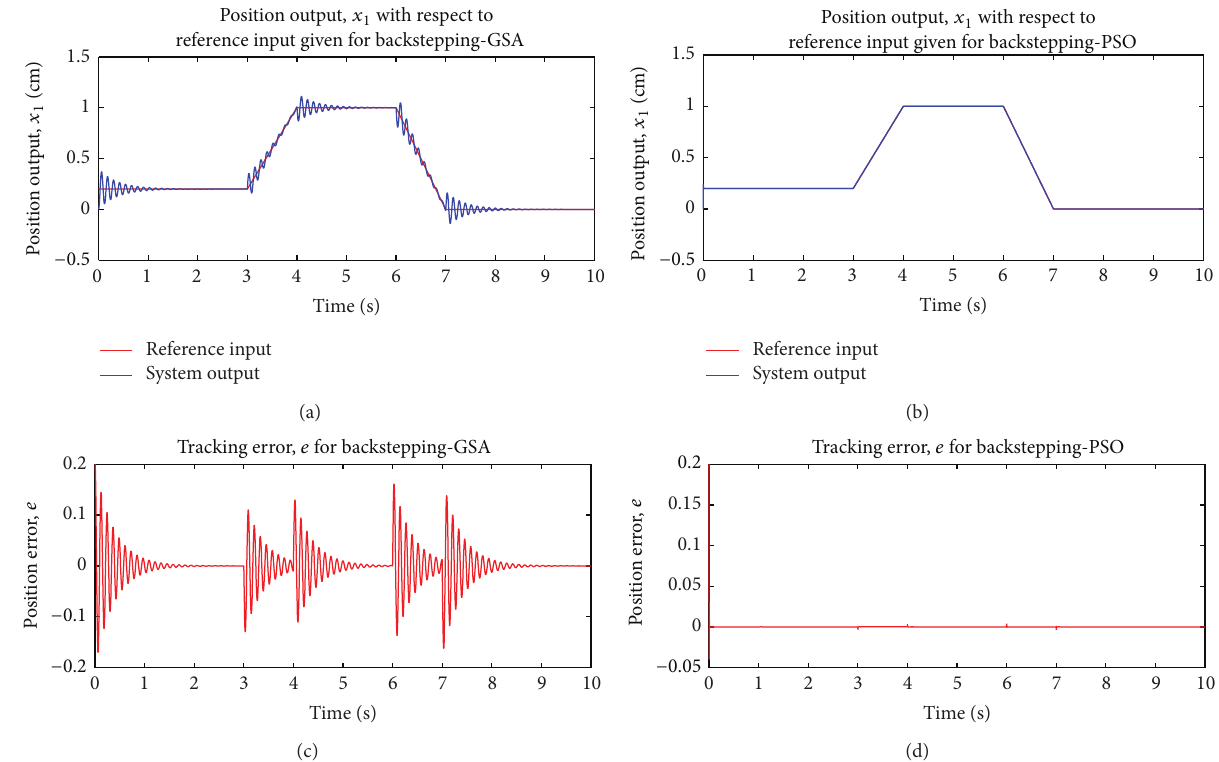
Figure 3: Position output with respect to reference input given and tracking error for backstepping-PSO and backstepping-GSA with step disturbance.